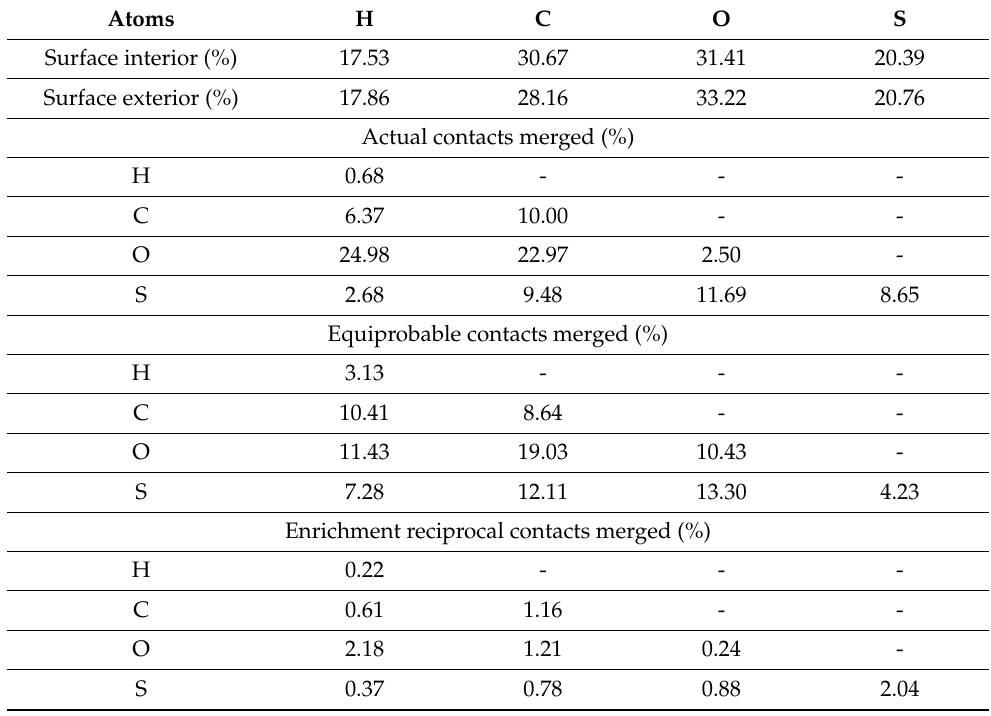
Table 2. Hirshfeld contact surfaces and enhancement ratios ( E ) for 4 . Atoms